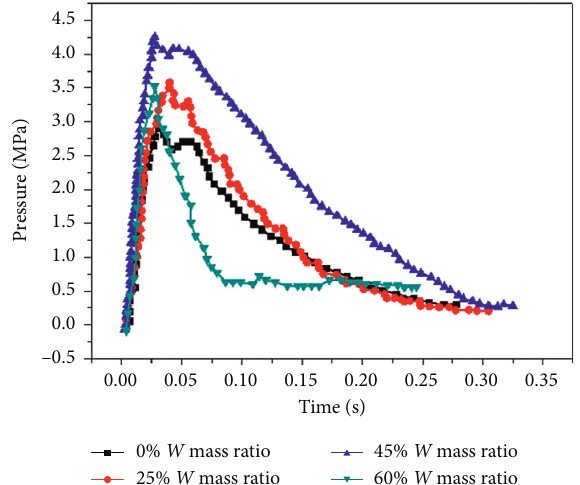
Figure 15: Comparison of the pressure-time curves of the Al/ PTFE/W energetic jets with different W contents.